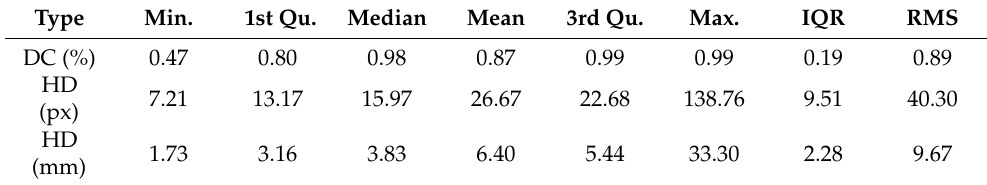
Table 1. DC and HD statistics obtained from the segmentation results.